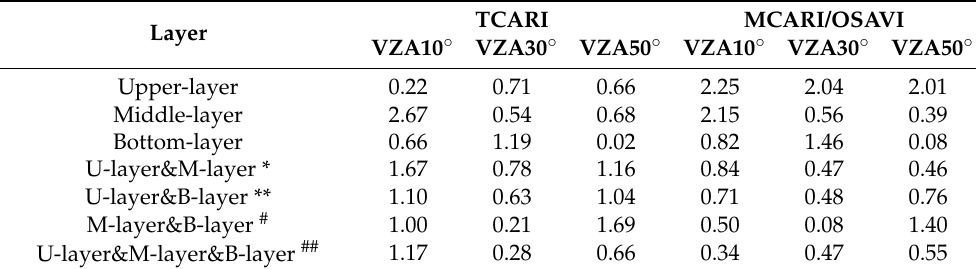
Table 5. F statistic of the interaction of different factors.